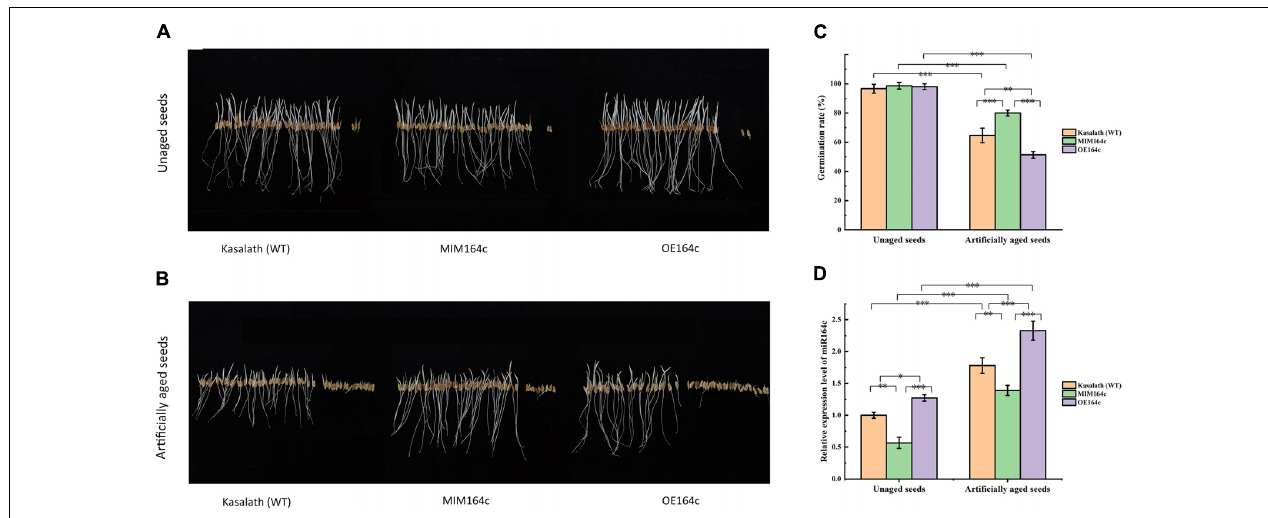
FIGURE 1 | Analysis of seed morphological phenotypes and miR164c expression levels in the seeds of the wild-type rice cultivar “Kasalath” (WT), miRNA164c-silenced line (MIM164c; ST), and miR164c overexpression line (OE164c; OT) before and after artificial aging. (A,B) Morphological phenotypes of germinating seeds. (C) Seed germination rates. (D) miR164c expression levels. Photographs shown in A and B were taken on the third day of germination. Data represent mean ± SD ( n = 3). Significant differences in seed germination rates and miR164c expression levels among the different rice genotypes were